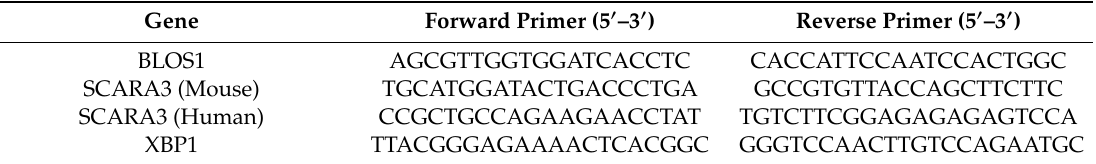
Table 1. List of